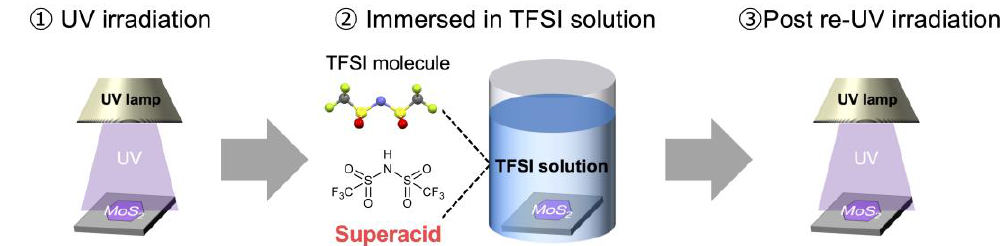
Figure 2. Illustrative image of the process applied to the bilayer MoS 2 .